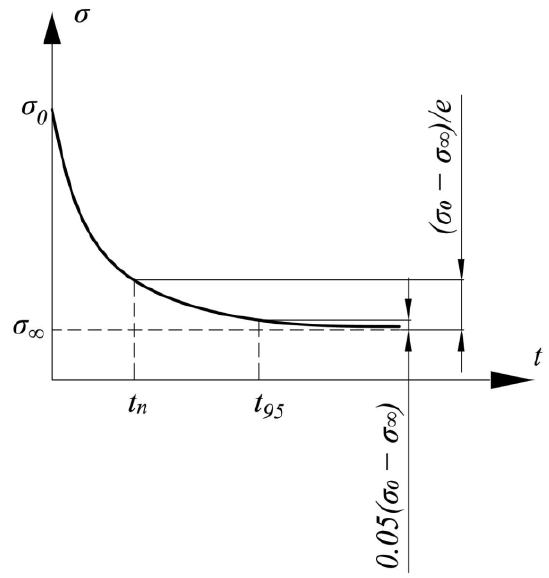
Figure 1. Typical stress relaxation curve.